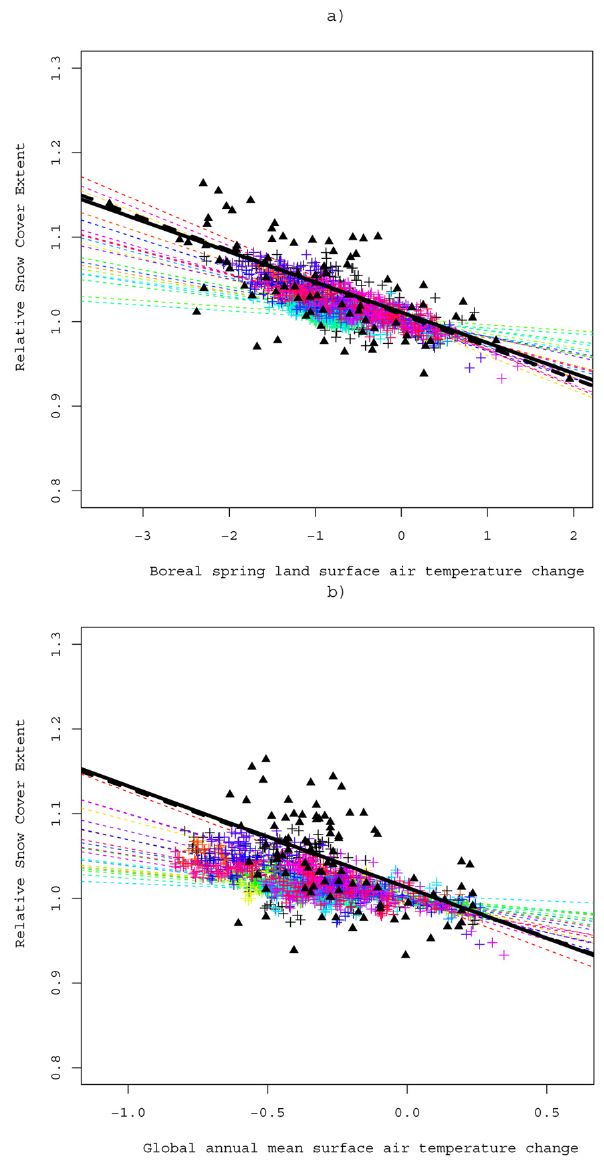
Fig. 6. Observed (black triangles and thick black lines) and sim- ulated (crosses and dashed lines, colors representing the individ- ual models) relationship between the normalized NH-ifl March– April SCE (y-axis) and temperature anomalies (x-axis). (a) x-axis: March–April temperature anomalies for land areas north of 50 ◦ N (CRUTEM4); (b) x-axis: global annual mean temperature anoma- lies (HadCRUT4). Data and model output are represented for the period 1922–2005. The reference period for temperature and SCE anomalies is 1986–2005. The linear regressions (lines) were calcu- lated for the period 1922–2005, except for the dashed thick line, which shows the regression calculated for the observations over the period 1979–2005.